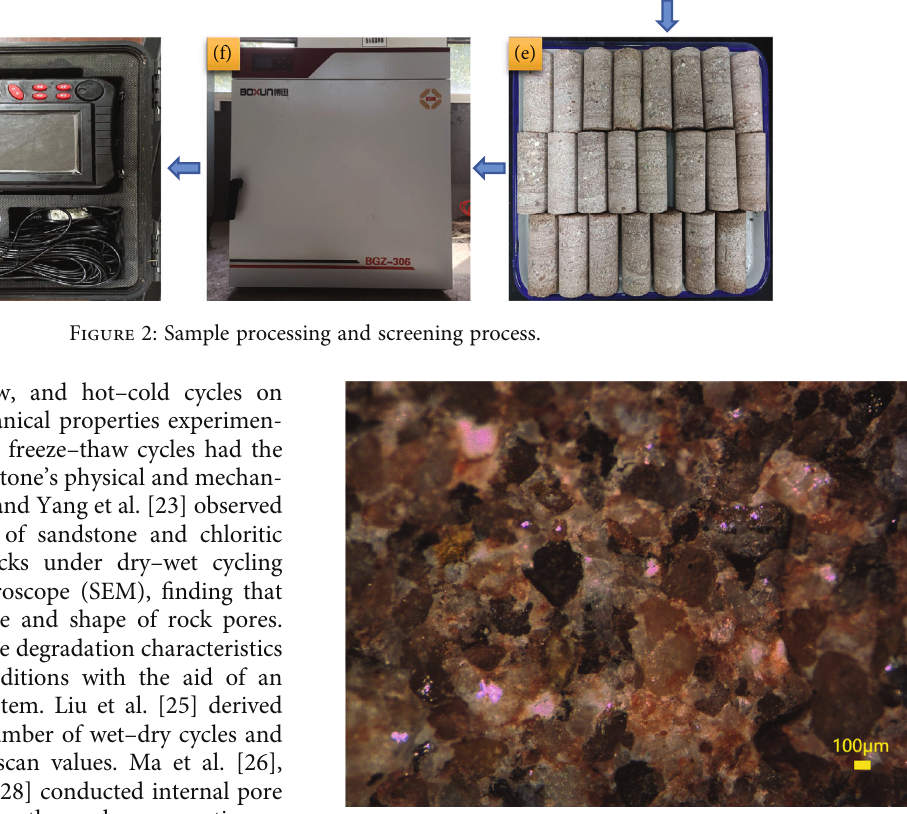
Figure 3: Surface morphology of sample observed by